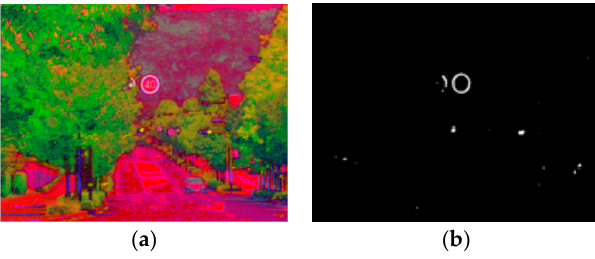
Figure 2. ( a ) Hue, Saturation and Value (HSV) image and ( b ) image of extracted −1/3π ≤ H ≤ 1/6π Hue regions when a threshold value is set for Hue (H) in order to extract the red ring at the outer edge of the sign.